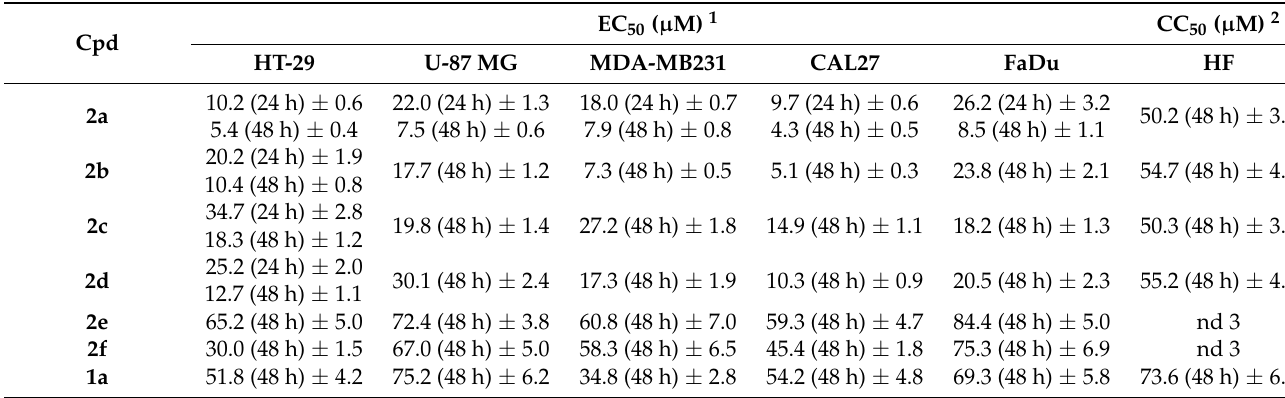
Table 3. Cytotoxicity and antitumor activities of the newly synthesized compounds 2a – f in comparison with reference compound 1a